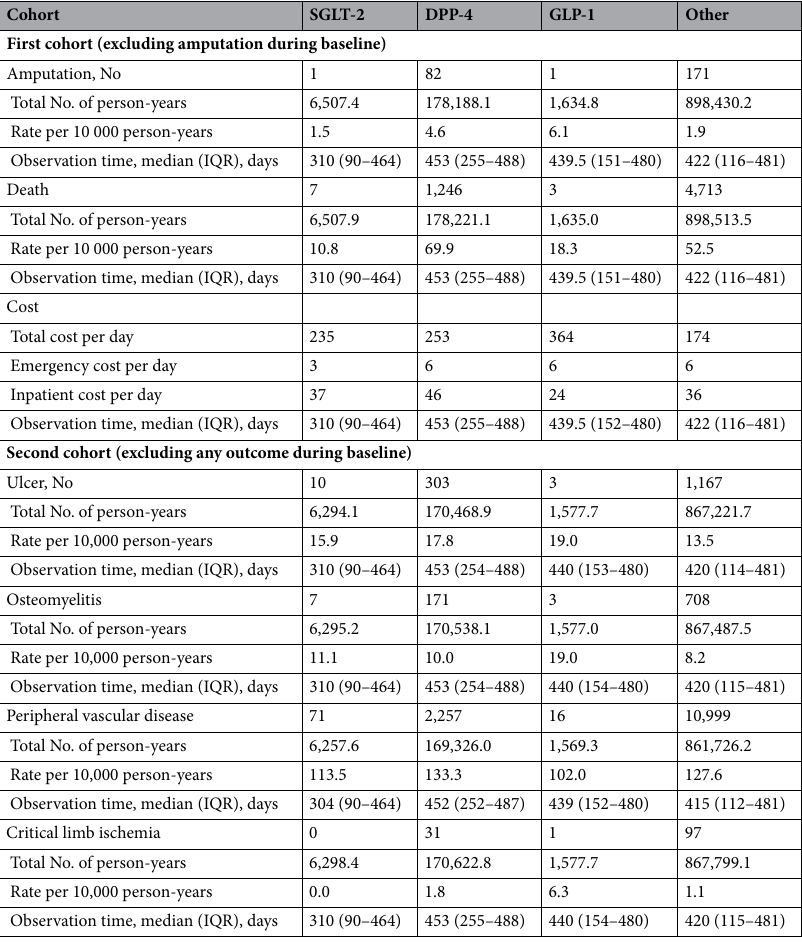
DPP-4, dipeptidyl peptidase 4; GLP-1, glucagon-like peptide 1; IQR, interquartile range; SGLT-2, sodium- glucose cotransporter